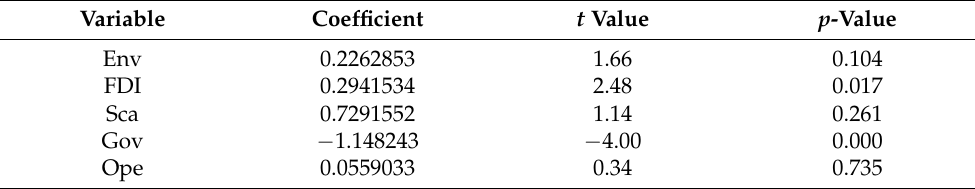
Table 4. Regression results.